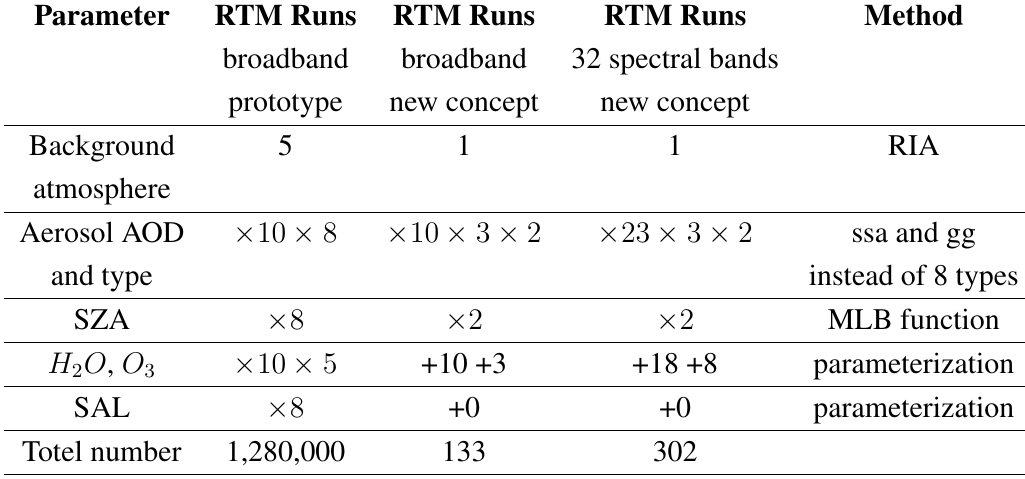
Reduction of needed RTM runs, comparison of original prototype CM-SAF algorithm with the new algorithm. RIA: RTM based Impact Analysis, analysis of Principal Components and Symmetries. MLB: Modified Lambert–Beer